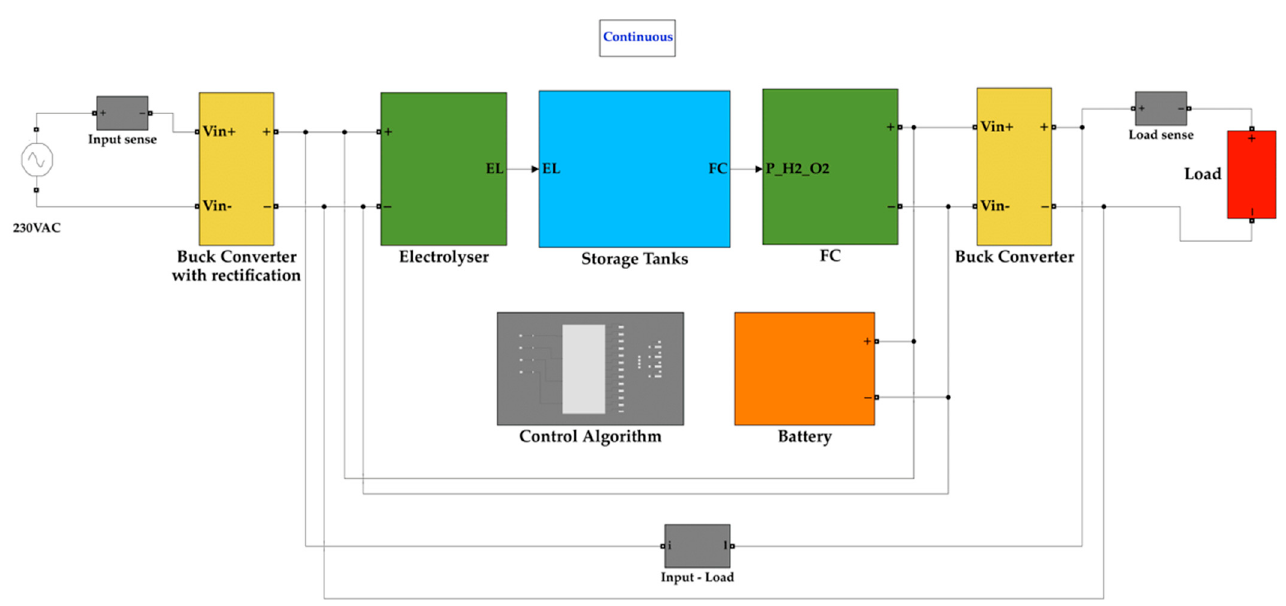
Table 1. Switching algorithm with legend.